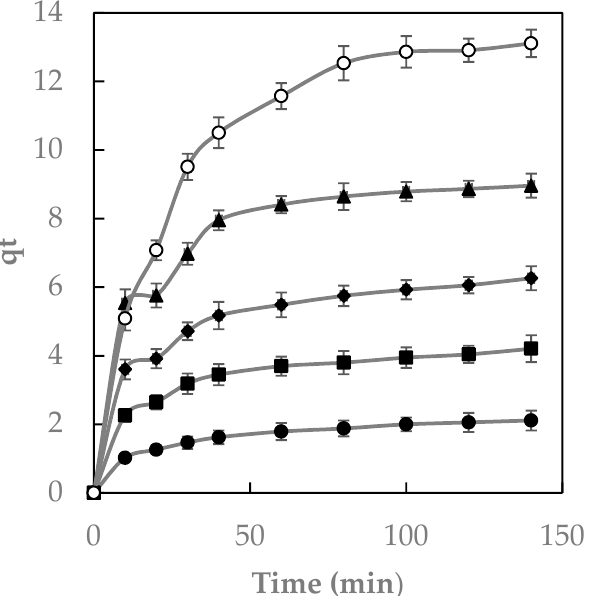
Figure 11. The kinetics analysis ( A ) pseudo-first model; ( B ) pseudo-second model; ( C ) intraparticle di ff usion model. Co: 50 ( ● ), 100 ( ■ ), 150 ( ⯁ ), 200 ( ▲ ), and 300 ( ○ ) mg/L. N = 3. Figure 10. The effect of contact time at different dye concentrations: 50 ( • ), 100 ( (cid:4) ), 150 ( Figure 10. The e ff ect of contact time at di ff erent dye concentrations: 50 ( ● ), 100 ( ■ ), 150 ( ⯁ ), 200 ( ▲ ), and 300 ( ○ ) mg/L. N = 3.